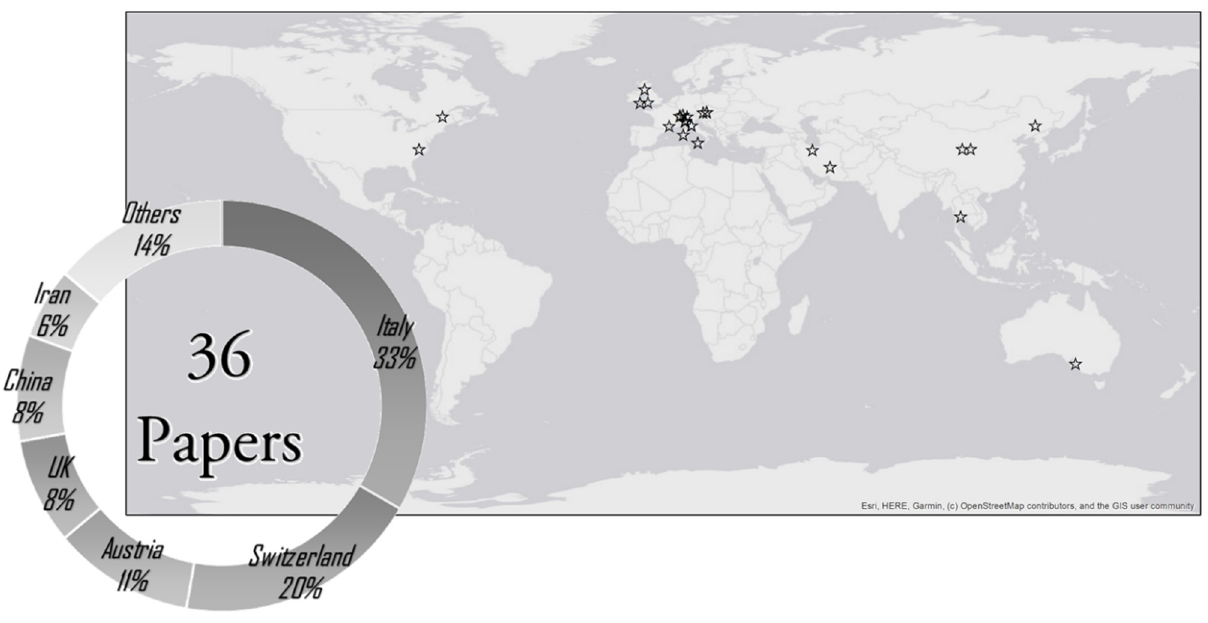
Figure 3. Worldwide distribution of the revised studies published during the period 2015–2020 regarding the root reinforcement. Points are located based on corresponding author’s affiliation.